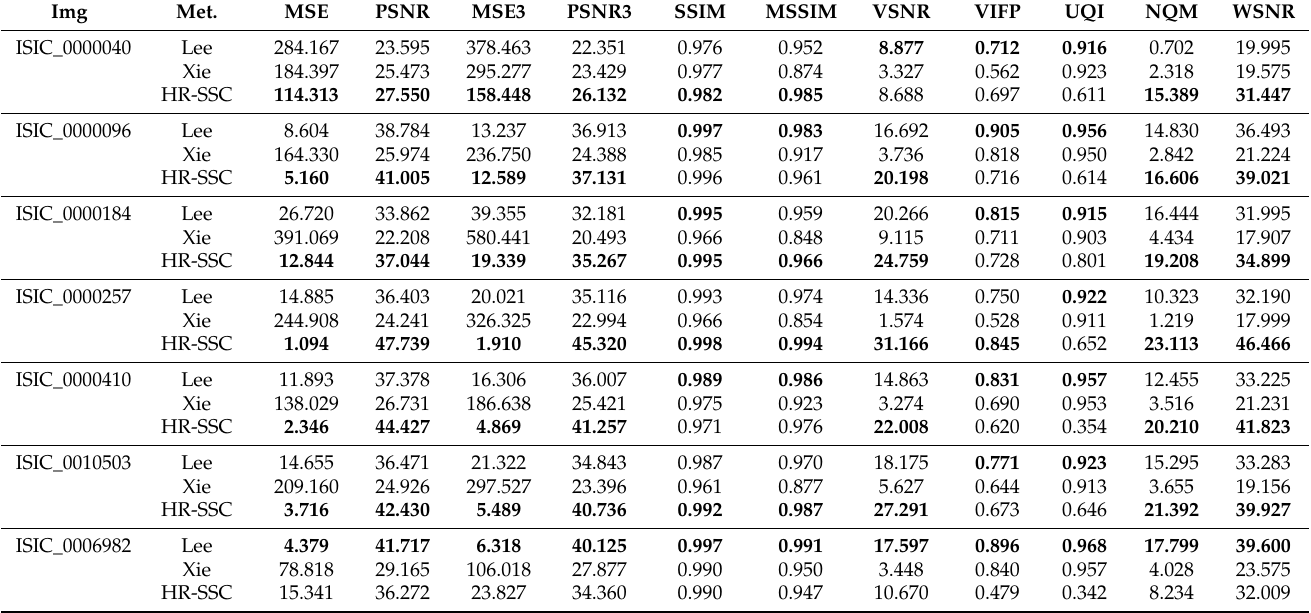
Table 3. Quality evaluation of the results on the sHSim-data —best results are in bold. Img